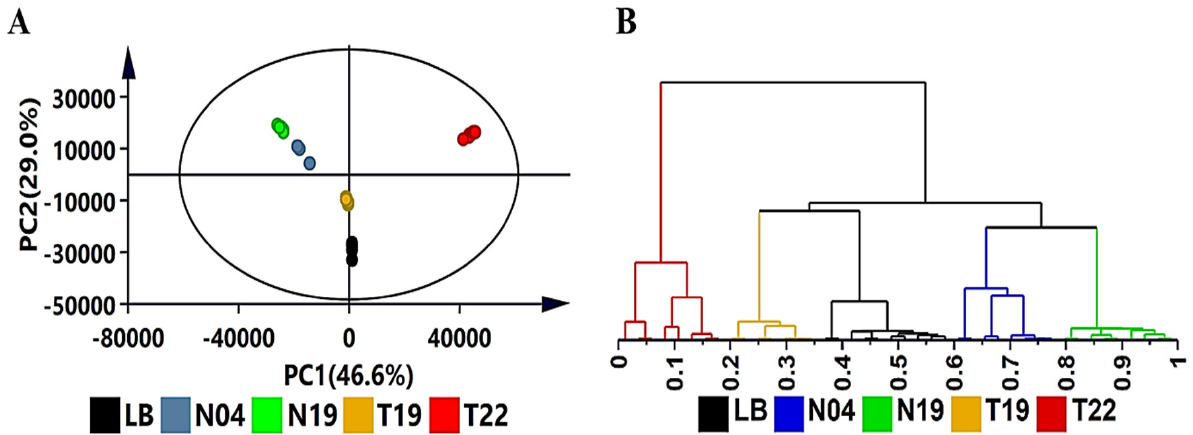
Figure 1. Exploratory data analysis of volatile organic compounds produced by the four PGPR strains (N19, N04, T19, T22) with unsupervised chemometric methods. LB = control comprising of uninoculated Luria-Bertani medium. ( A ): A PCA scores scatter plot of all the samples colored according to PGPR strain. The ellipse represents the Hotelling’s T 2 distribution with 95% confidence. The PCA model presented here was a 5-component model, with R 2 X of 93.6% and Q 2 (cum) of 91.3%. ( B ): The HCA dendrogram corresponding to the PC analysis. Unsupervised statistical analysis is used to generate the subgrouping of samples based on similar observations in ( A ), whereas the HCA dendrogram shows the hierarchical relationship between samples ( B ).